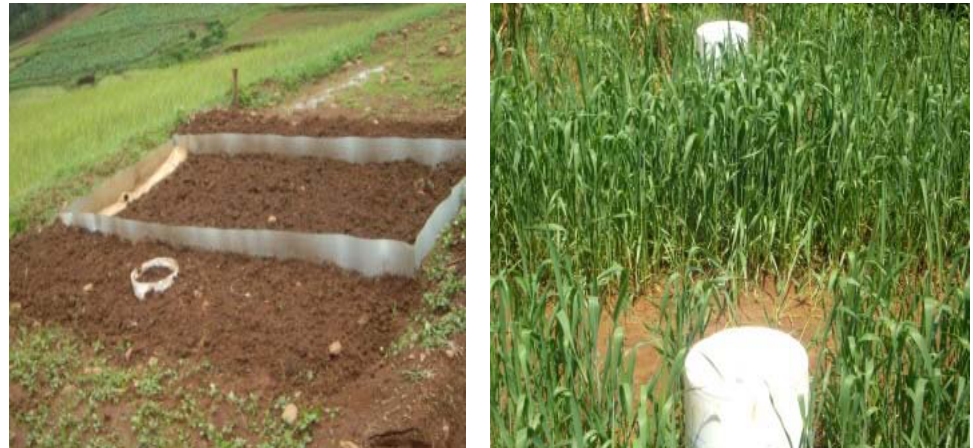
Figure 2. Static gas sampling chamber collar installed in the field adjacent to runoff plots ( left ) and static chambers with covers on the top ready for gas sampling ( right ).